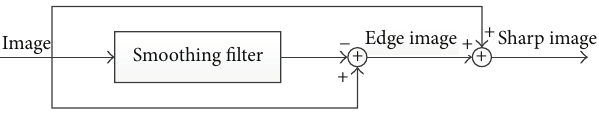
Figure 2: Unsharp masking contrast